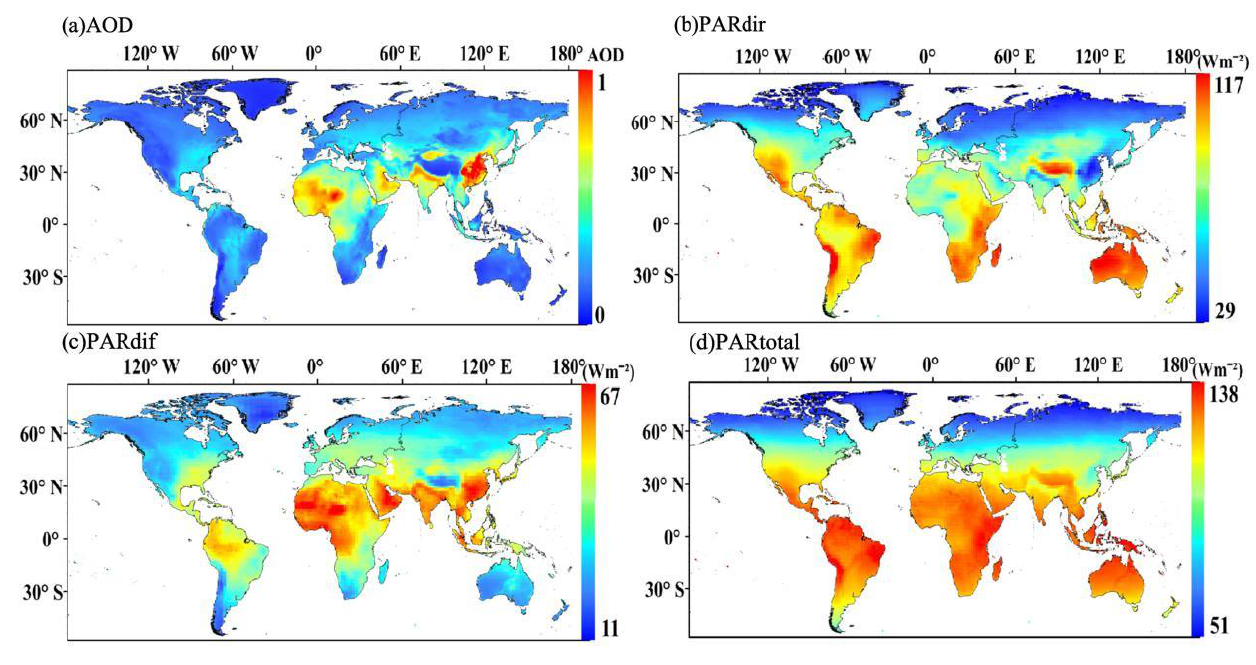
Figure 2. The spatial distribution of annual mean values of ( a ) AOD, ( b ) PAR dir (W m − 2 ), ( c ) PAR dif (W m − 2 ), and ( d ) PAR total (W m − 2 ) from 2000 to 2014 globally.